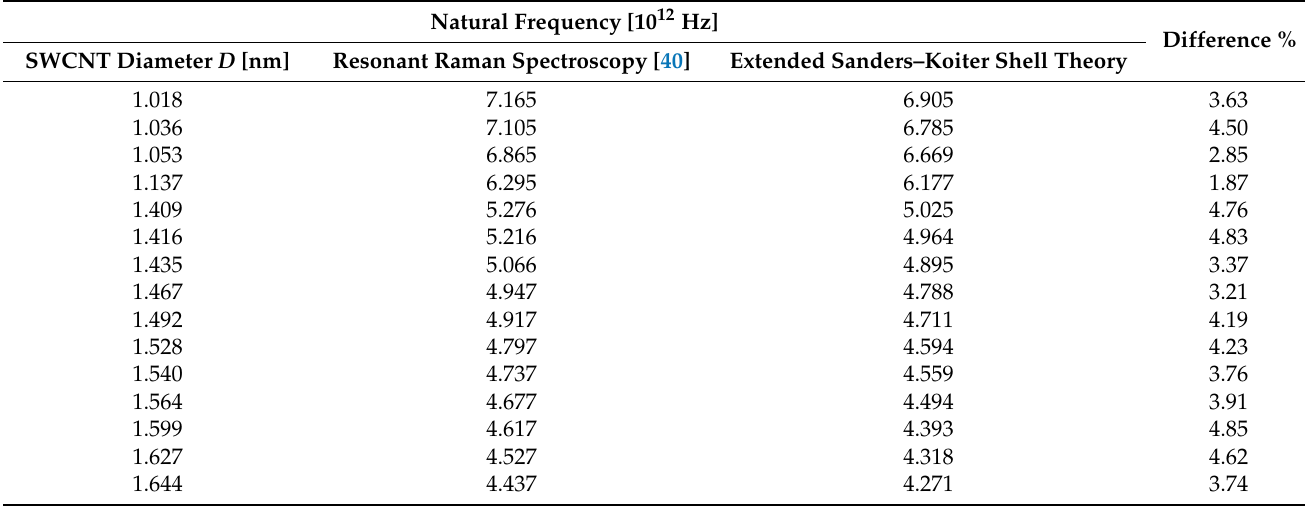
Table 2. Natural frequencies of the radial breathing mode ( m = 0, n = 0). Comparisons between resonant Raman spectroscopy and extended Sanders–Koiter shell theory. Free–free SWCNT with mechanical parameters of Table